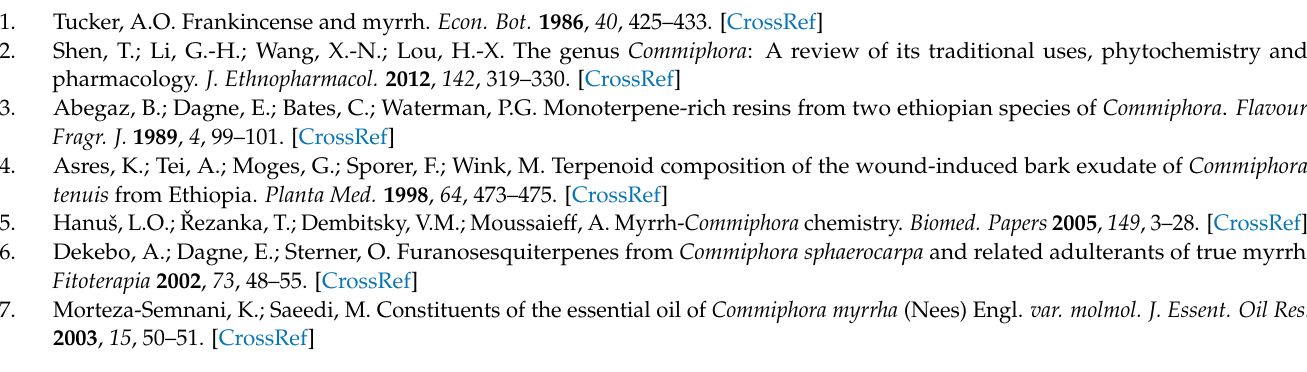
m: multiplet). Table S9. 1 H and 13 C NMR data (600 and 150 MHz, respectively) for compound 34 (CDCl 3 , δ in ppm, J in Hz, s: singlet, d: doublet, br: broad, and m: multiplet). Figure S2. CD spectra of compounds 1 , 3 – 12 and 14 – 17 in methanol. [ θ ] in [( ◦ cm 2 ) · dmol − 1 ]. Figure S3. CD spectra of compounds 18 , 20 and 22 – 34 in methanol. [ θ ] in [( ◦ cm 2 ) · dmol − 1 ]. Figure S4. 1 H (600 MHz, A) and 13 C NMR spectra (150 MHz, B) of 1 (in CDCl 3 ). Figure S5. 1 H (600 MHz, A) and 13 C NMR spectra (150 MHz, B) of 2 (in CDCl 3 ). Figure S6. 1 H (600 MHz, A) and 13 C NMR spectra (150 MHz, B) of 3 (in CDCl 3 ). Figure S7. 1 H (600 MHz, A) and 13 C NMR spectra (150 MHz, B) of 4 (in CDCl 3 ). Figure S8. 1 H (600 MHz, A) and 13 C NMR spectra (150 MHz, B) of 5 (in CDCl 3 ). Figure S9. 1 H (400 MHz, A) and 13 C NMR spectra (100 MHz, B) of 6 (in CDCl 3 ). Figure S10. 1 H (600 MHz, A) and 13 C NMR spectra (150 MHz, B) of 7 (in CDCl 1 H (600 MHz, A) and 13 C NMR spectra 3 ). Figure S11. (150 MHz, B) of 8 (in CDCl 3 ). Figure S12. 1 H (600 MHz, A) and 13 C NMR spectra (150 MHz, B) of 23 (in CDCl 3 ). Figure S13. 1 H (600 MHz, A) and 13 C NMR spectra (150 MHz, B) of 24 (in CDCl 3 ). Figure S14. Influence of compounds 4 – 6 , 9 – 11 , 17 , 18 , 20 and 27 on the viability of HMEC-1 cells in the MTT assay (a) and on their TNF α -induced ICAM-1 expression (b). The test was performed with medium containing DMSO (0.15%, v / v ) without stimulation (u.c.), with TNF α (10 ng/mL, n.c.), and with both TNF α and parthenolide (5 µ M, Parth.) as positive control. Substances were applied in concentrations between 13 and 70 µ M. Data are presented as mean ± SEM (n =